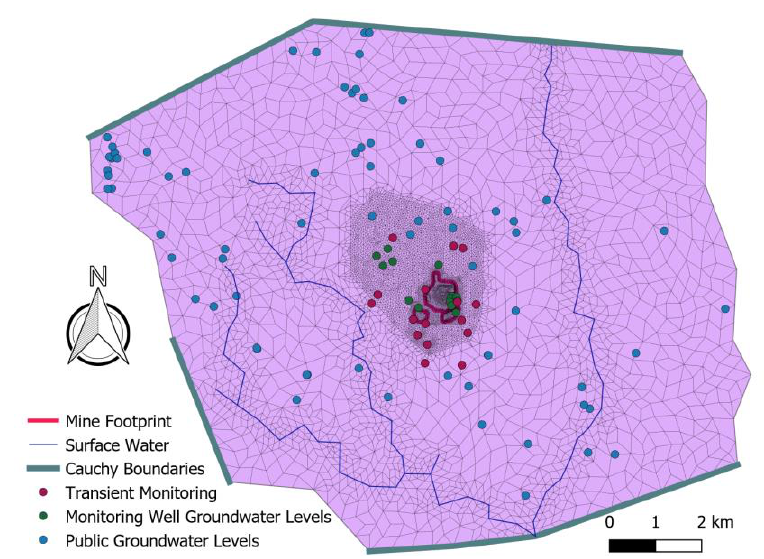
Figure 2. Numerical Model Mesh, Boundary Conditions, and Observation Data Locations. Model domain corresponds to Pink shaded area shown in Figure 1.